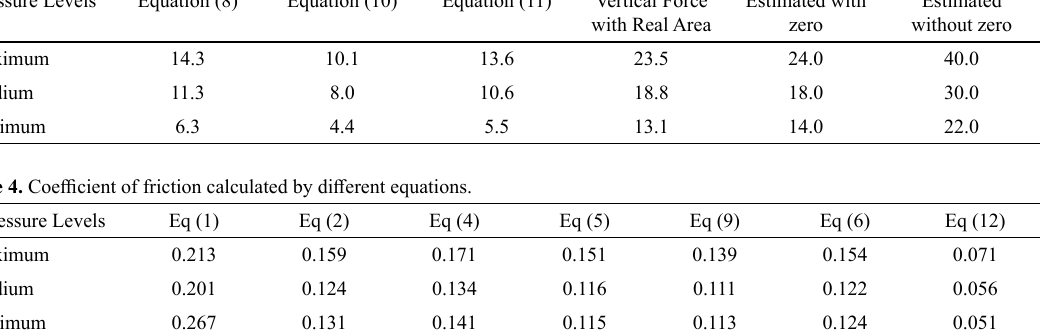
Table 3. Contact pressure for several different calculation forms. Values in MPa. Pressure